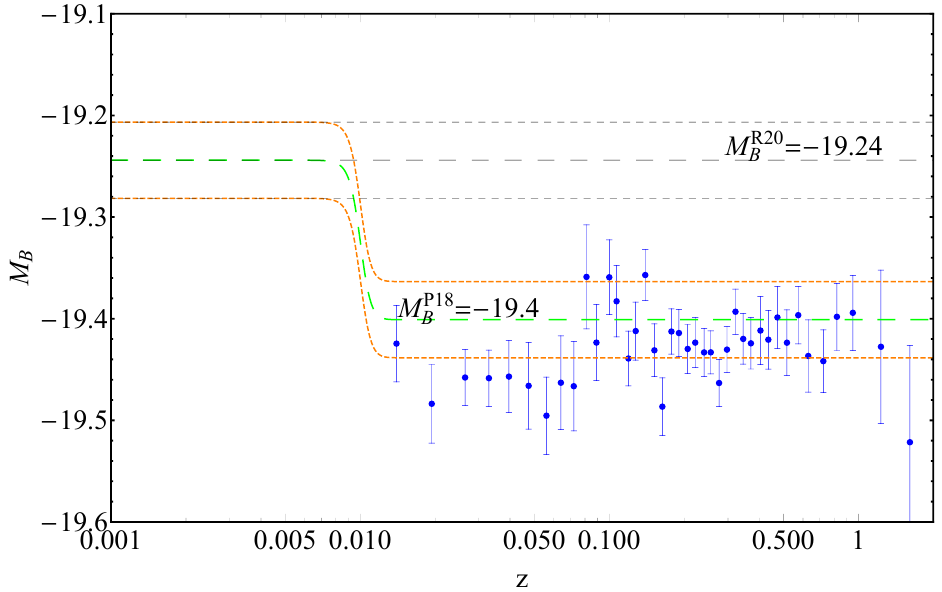
Figure 1. The SnIa absolute magnitudes obtained as M i = m i − µ ( z i ) of the binned Pantheon sample [5] assuming Planck/ Λ CDM luminosity distance. The data are inconsistent with the M R20 of Equation (4), but they become consistent if there is a transition in the absolute magnitude with amplitude ∆ M ≈ − 0.2. Note that in this model there is no transition in the Hubble function H ( z )